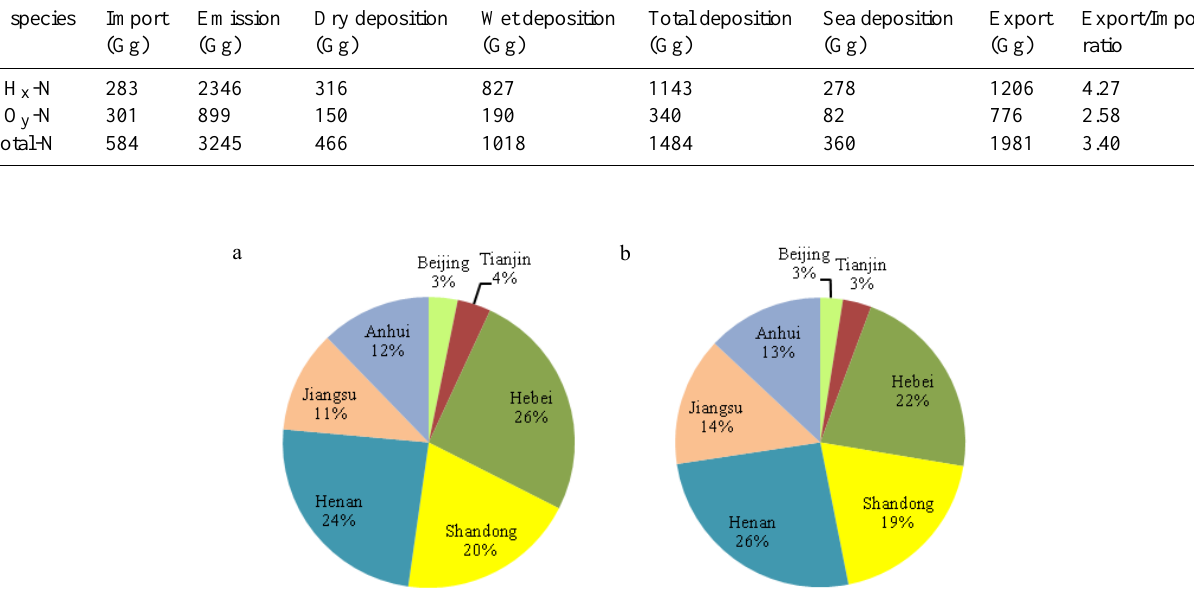
Fig. 5. Contributions of areas (a) and N deposition budgets (b) in the NCP at province level (only the areas and N deposition budgets of the seven provinces within the NCP were included; areas and N deposition budgets of the seven provinces outside the NCP were omitted).